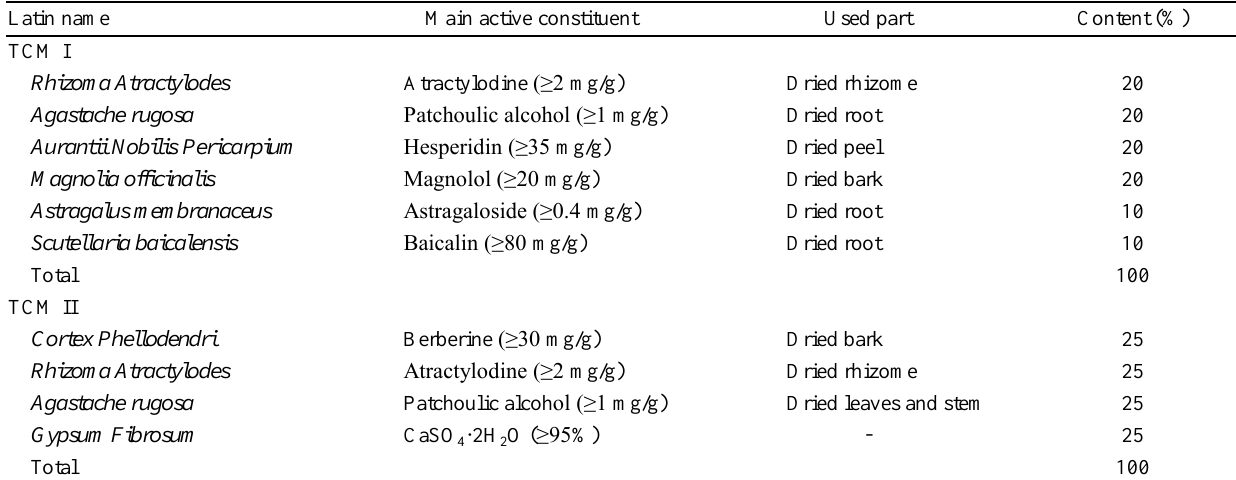
Table 3. Composition and main active constituents of TCM I and TCM II (air dry basis)